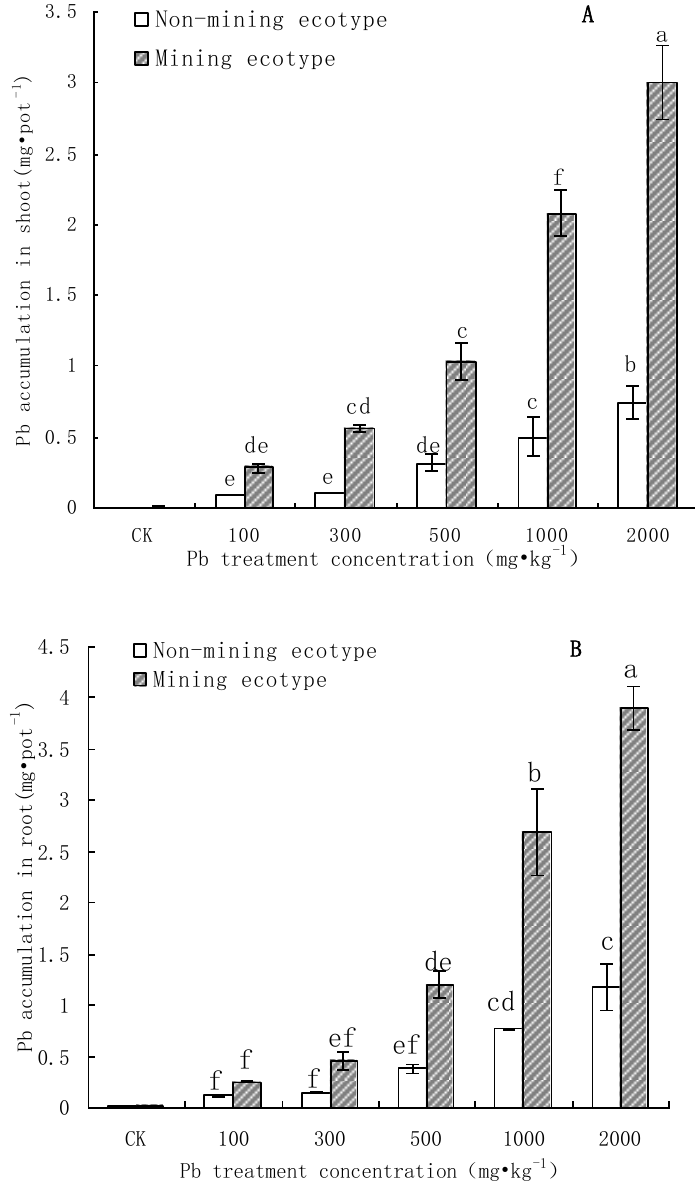
Figure 4. Pb accumulation in root and shoot of Two ecotypes of M. floridulus under different Pb treatment (( A ) in shoot, ( B ) in root). Note: Error bars indicate standard deviation; different letters in the same group indicate significant difference at p < 0.05 according to Duncan’s multiple range tests.